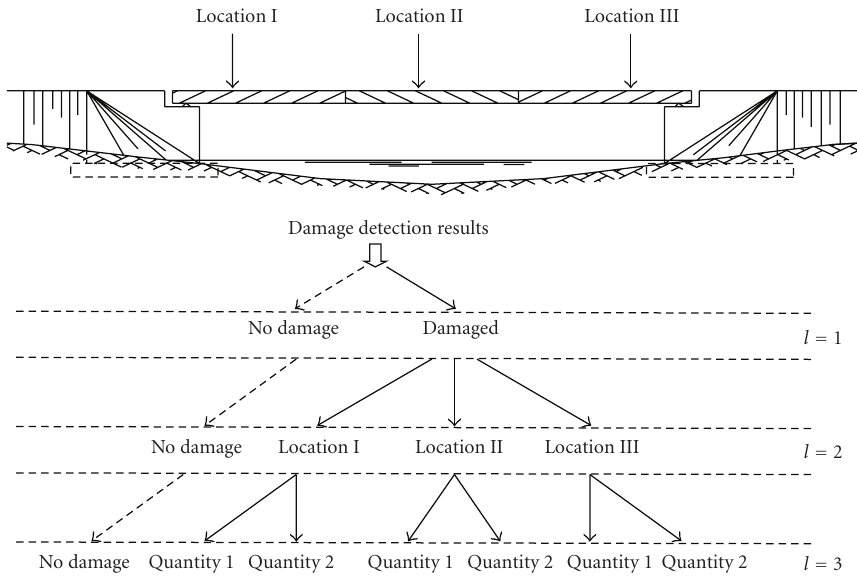
Figure 1: Three damage resolutions of damage detection